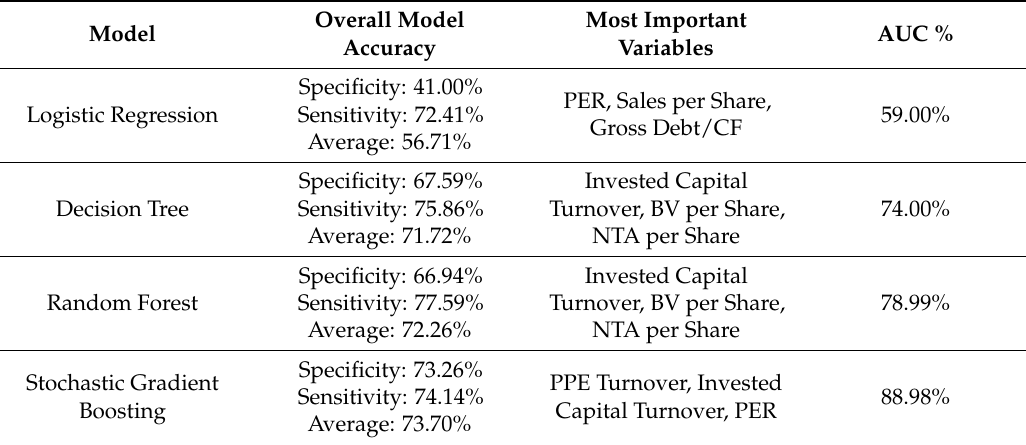
Table 9. Model comparison table using test